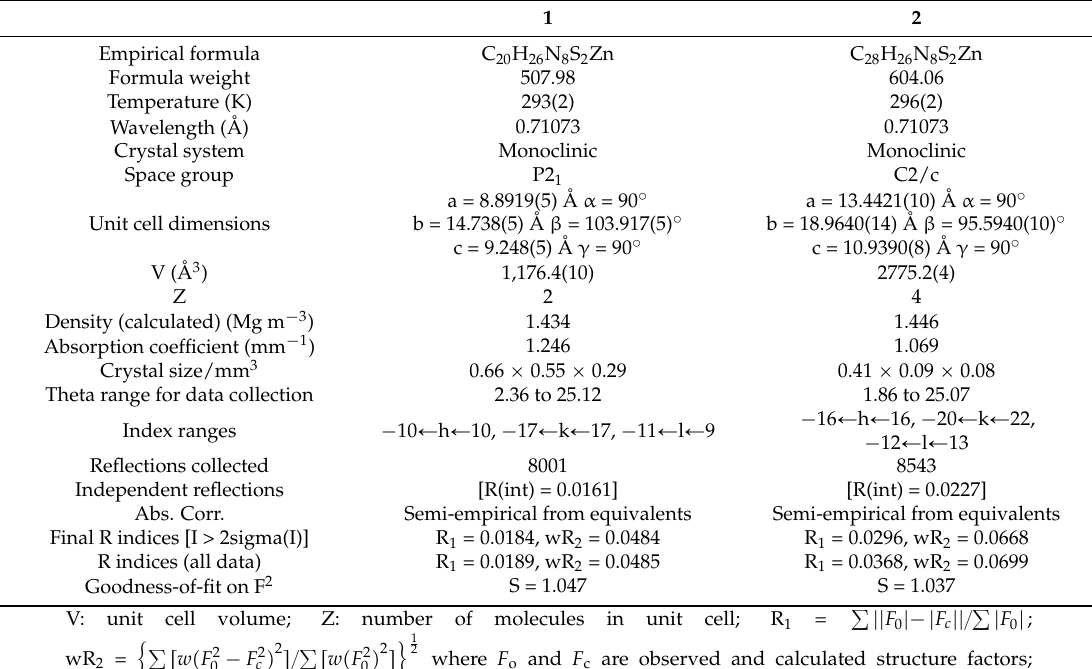
Table 4. Crystal data and structural refinement for [Zn(atc-Et) 2 ] ( 1 ) and [Zn(atc-Ph) 2 ] ( 2